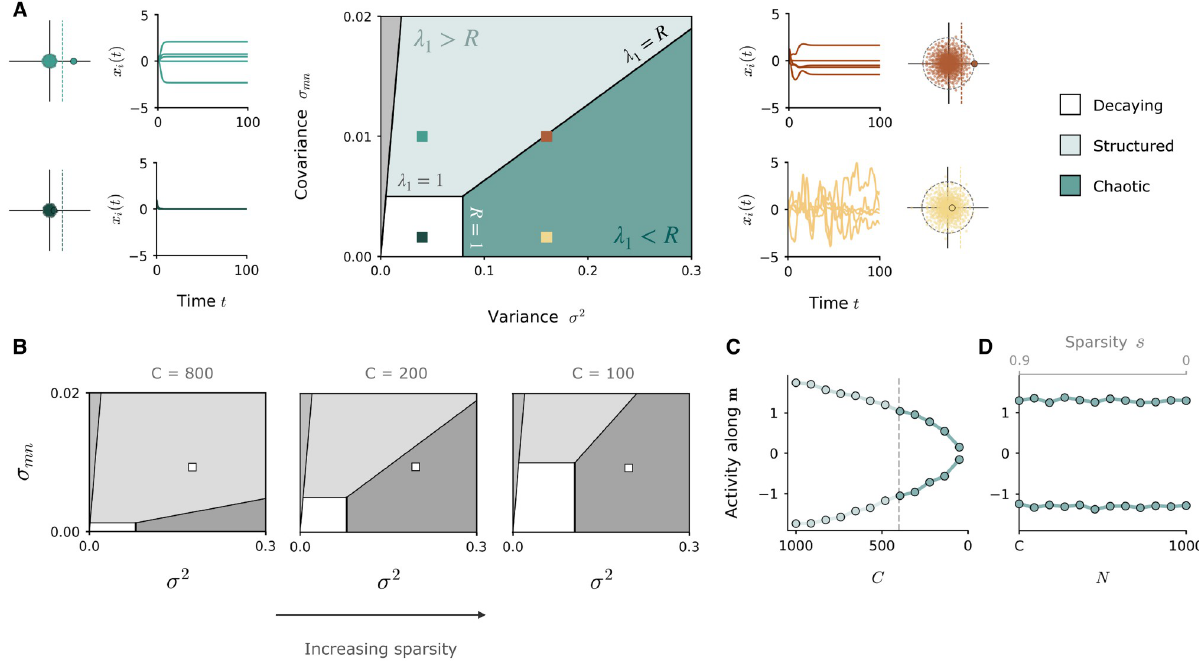
Fig 5. Dynamical regimes of autonomous network activity at high sparsity. A : Dynamics of a sparsified rank-one network in the high-sparsity regime where P = m and the number of non-zero connections C is fixed. The variance σ 2 and covariance σ of the connectivity vectors respectively ij i n j mn control the bulk radius and outlier of the eigenvalue distribution. Centre: Phase diagram of dynamical regimes in the variance-covariance plane, for C = 200 and N = 1000. The transition from structured to chaotic activity occurs when the bulk radius surpasses the location of the outlier. Side panels: samples of autonomous dynamics of simulated networks situated in different dynamical regimes (coloured squares). Eigenspectra of each network accompany each panel, showing bulk distribution (small dots) and outlier (large dot) with respect to the instability limit at unity (dashed line). B : Modification of the phase diagram when N is fixed ( N = 1000) and C is reduced to increase the degree of sparsity. C : Projection of activity along m for a network with fixed variance σ 2 and covariance σ (situated at the white square in phase diagrams in B ) while N is fixed ( N = 1000) and C is decreased. mn The network activity progressively loses structure along m since the eigenvalue outlier is reduced. D : Same as C , but with C fixed ( C = 600) and N increased. The outlier is independent of N , so structured dynamics can be